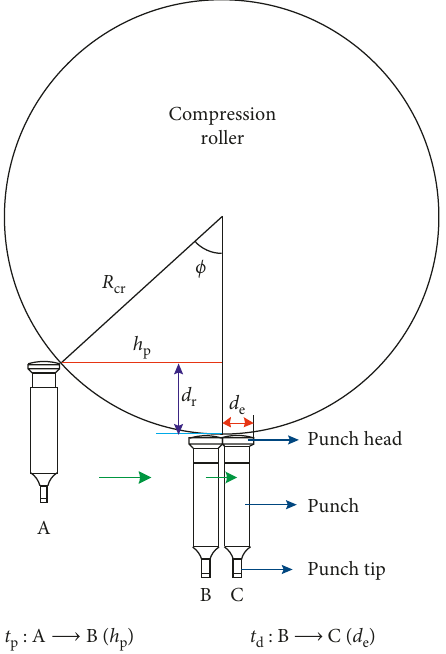
Figure 7: Two time periods of